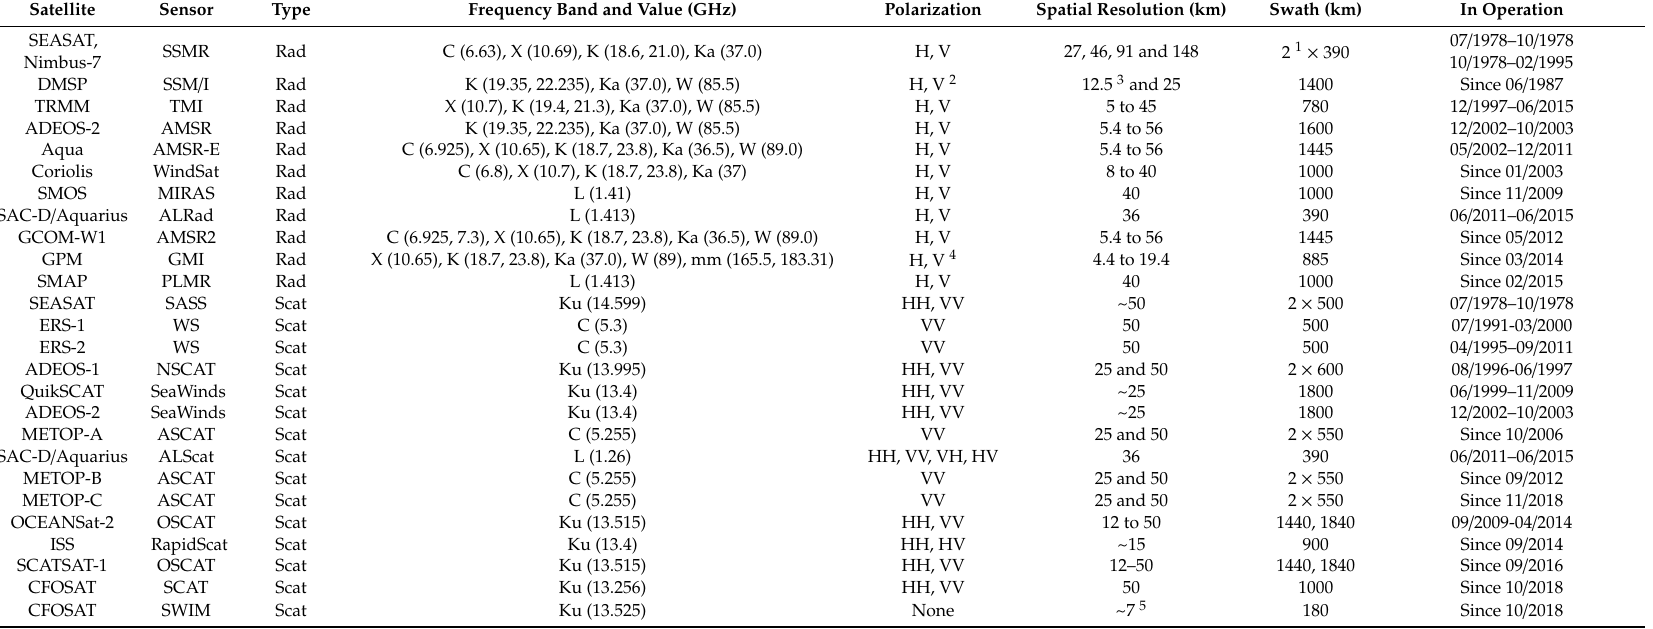
Table 1. Main characteristics of the radiometers (Rad) and scatterometers (Scat) onboard satellite platforms which were used or could be used for vegetation optical depth (VOD)